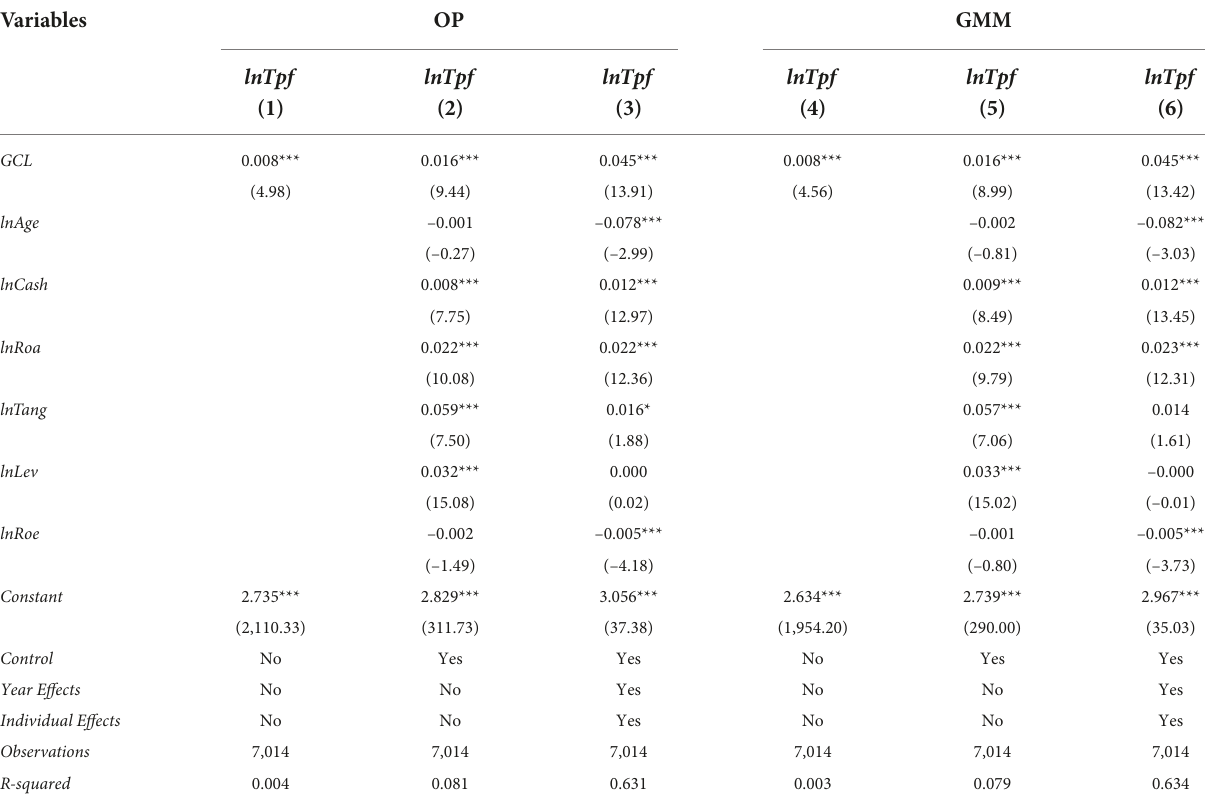
TABLE 4 Robustness tests II: OP &